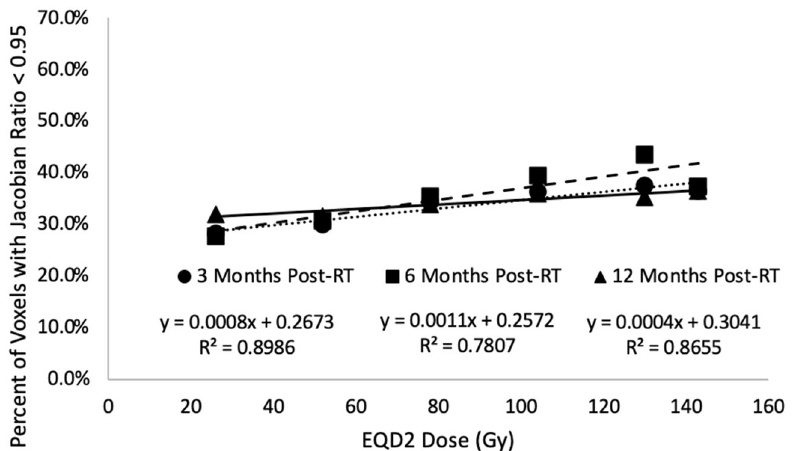
Figure 7. ( A ) Percent of voxels experiencing a 5 % or greater reduction in Jacobian value post-RT at each dose level in the humans. Results show a linear increase in the percent of voxels experiencing the reduction in ventilation with increasing dose. Data is shown at 3, 6 and 12 months post-RT. The number of subjects analyzed at each timepoint are 19, 13 and 11.